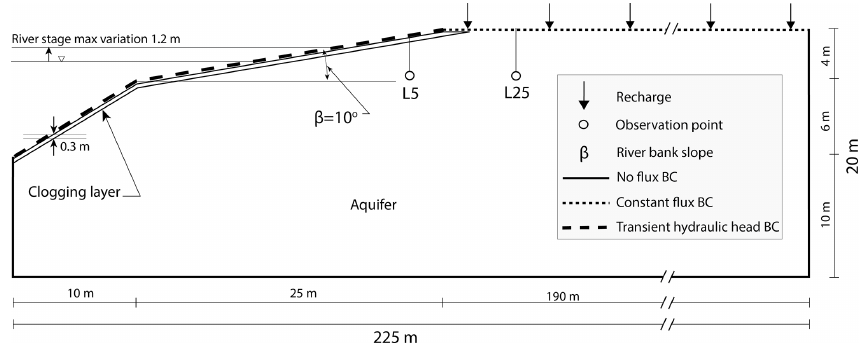
Figure 2. Conceptual model of the site showing boundary conditions (BC), clogging layer and observation points.